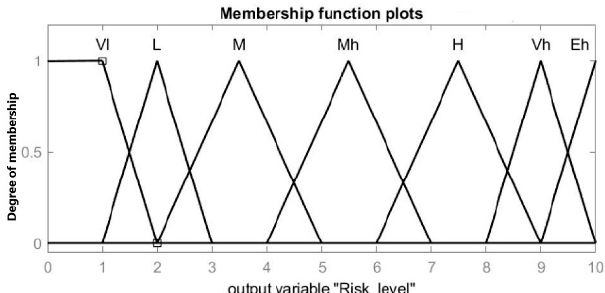
Figure 5. The membership functions of risk levels based on experts’ judgments.